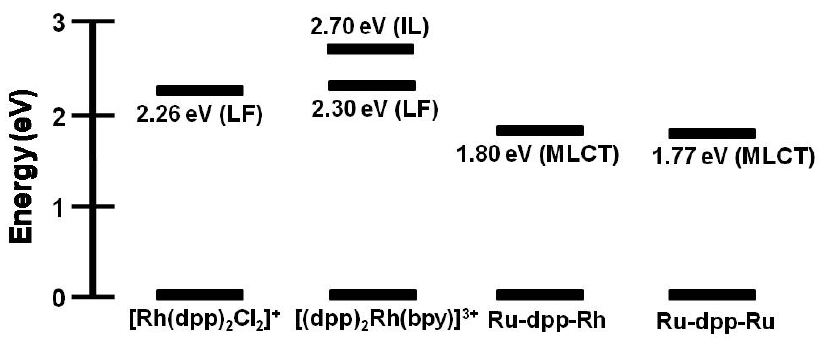
Figure 11. Relative E 0-0 energies of excited states associated with mono- and bimetallic species. Values of E 0-0 taken from 77 K emission measurements in 4:1 EtOH/MeOH glass. dpp = 2,3-bis(2-pyridyl)pyrazine, IL = intraligand excited state, LF = ligand field excited state, MLCT = metal-to-ligand charge transfer excited state. Adapted from